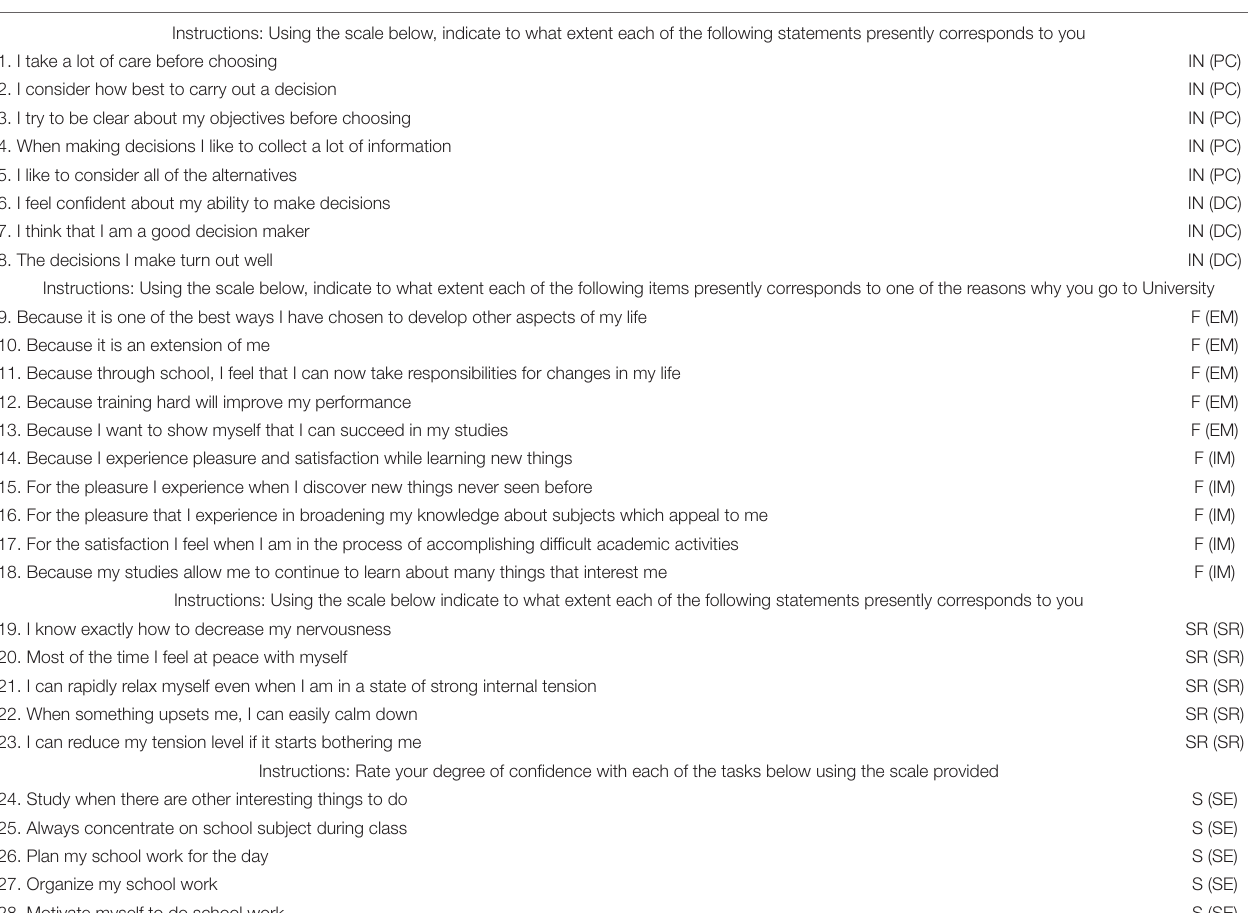
TABLE A1 | Agency for Learning Questionnaire Short Form (AFLQ-S) ( α = 0.90, CI 95 = 0.89,